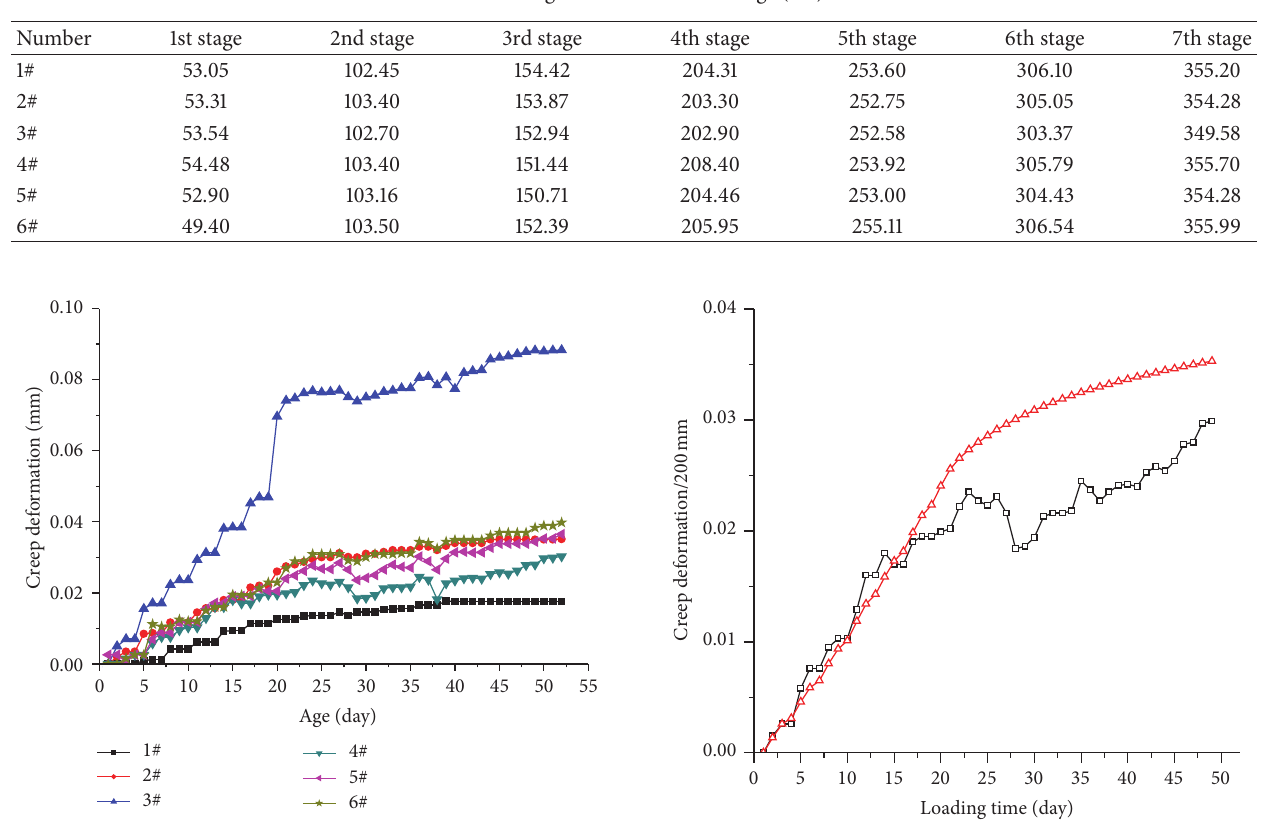
Figure 10: Longitudinal creep deformation curve obtained by FE model.